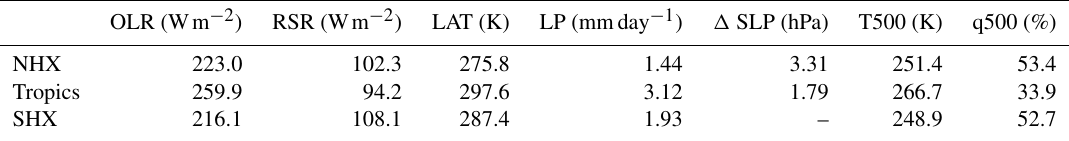
Table 2. Target values for optimisation cases. Each row corresponds to a region. The target value for net flux into the Earth is 0.5Wm − 2 .